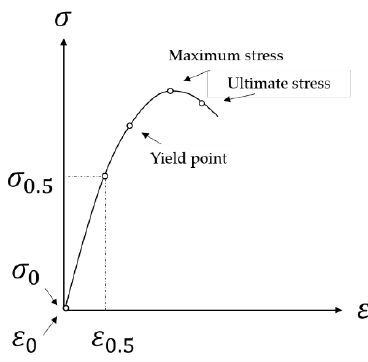
6 of 20 ( c ) Compressive strength test ( d ) Four-point bending test sketch ( e ) Strain gauge contacts ( f ) Flexural strength test experimental setup Figure 2. Compressive and flexural strength test schemes. Flexural stiffness test: The flexural stiffness revealed the stiffness measured in bend